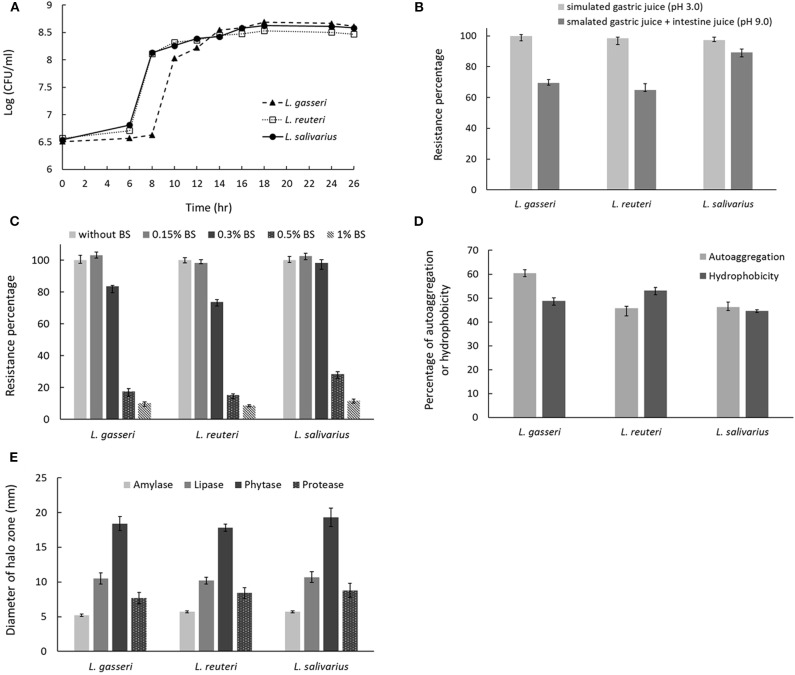
Characterization of probiotic properties of Lactobacillus strains. (A) The growth curves for the three Lactobacillus strains in MRS broth. The effect of incubation in (B) simulated gastric and intestinal juices or (C) bile salts on cell viability. (D) Evaluation of strain autoaggregation propensity and surface hydrophobicity. (E) Measurement of digestive enzyme activities, including amylase, lipase, phytase, and protease by spot inoculation method using different agar medium. Enzymatic activity was determined by measuring the diameter of clearing zone surrounding the colonies.